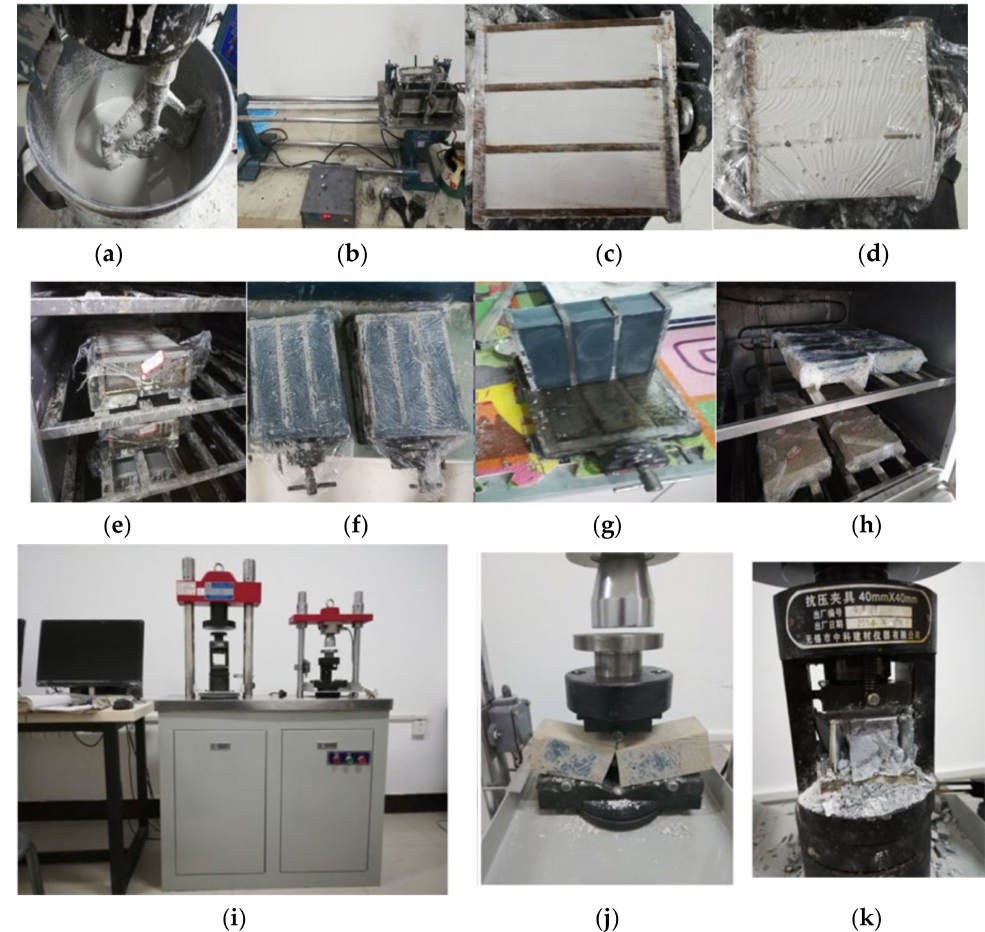
Figure 4. Preparation process and strength test of geopolymer: ( a ) stirring of slurry, ( b ) vibration of the vibrating table, ( c ) complete tapping, ( d ) covering with plastic wrap, ( e ) tank maintenance, ( f ) take out after 24 h, ( g ) demolding, ( h ) continue maintenance, ( i ) automatic compression and flexural testing machine, ( j ) flexural test, ( k ) compression